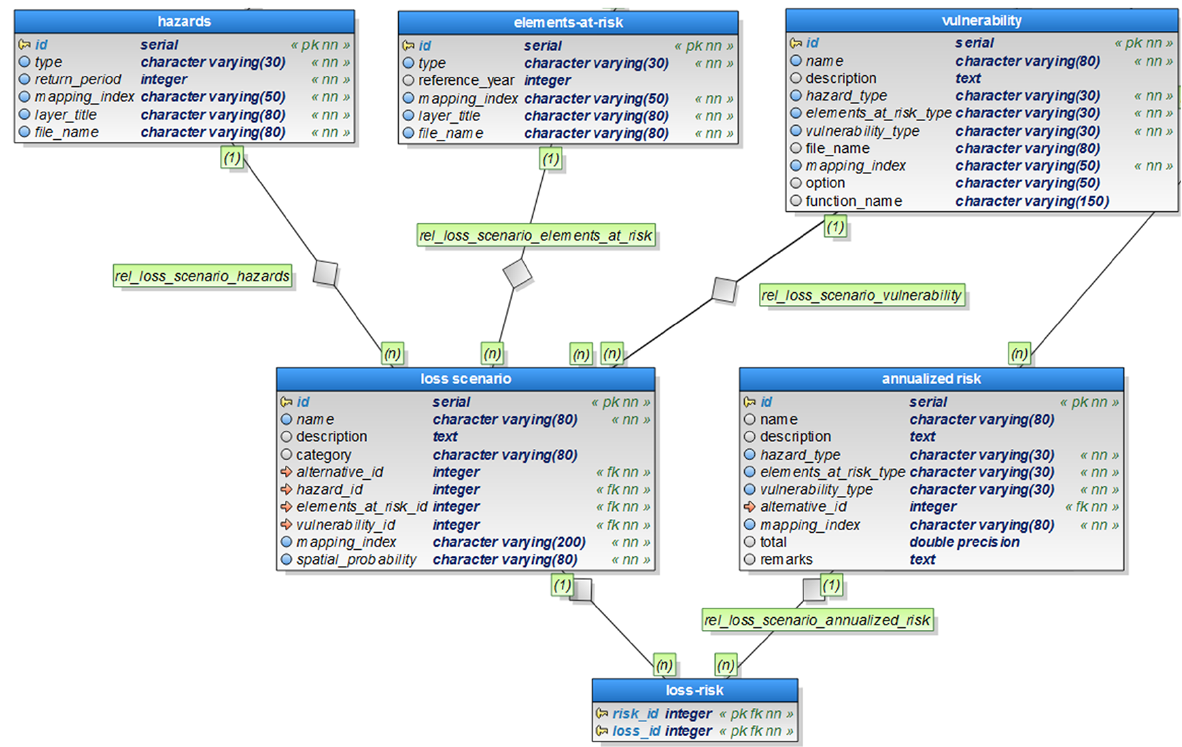
Figure 7. Data Model of Data Management (hazards, elements-at-risk and vulnerability tables) and Risk Analysis (loss scenario, loss-risk and annualized risk tables) modules. Three types of information can be seen in each table: the actual column name (e.g. id), the type of the column (e.g. serial) and the attribute of the column (e.g. (cid:28) pk nn (cid:29) represents that this is a primary key column and null values are not allowed for this